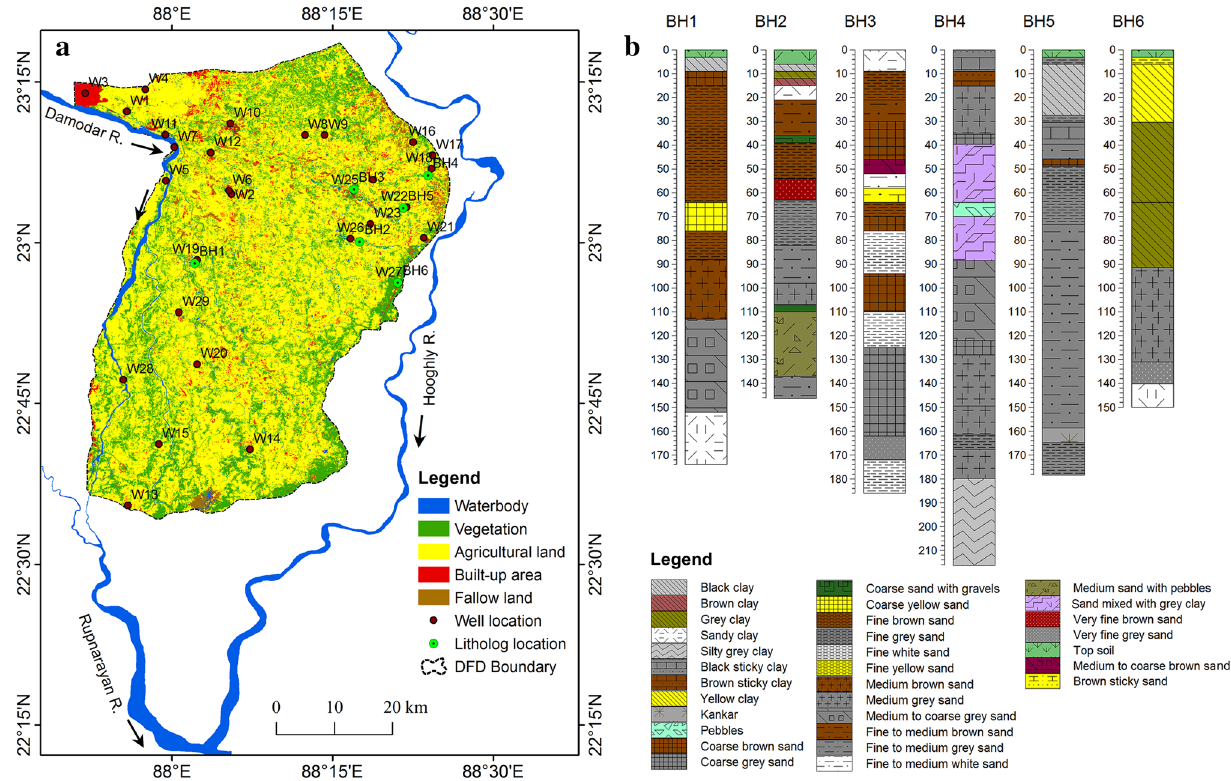
Fig. 9 a Land use and land cover, b lithological composition of the selected boreholes of the study